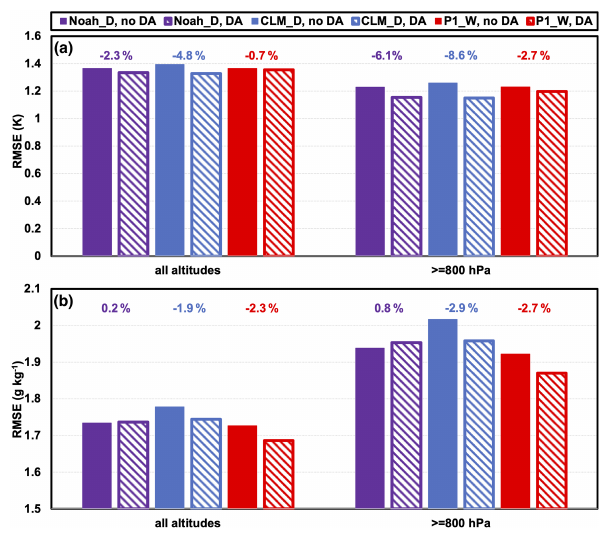
Figure 6. Evaluation of (a) air temperature and (b) water vapor mixing ratios from several WRF-Chem simulations with the B- 200 aircraft observations during the 2016 ACT-America campaign. The RMSEs are summarized in barplots based on model compar- isons against observations at all altitudes and near the surface (i.e., ≥ 800hPa). Colored texts above the barplots indicate the SMAP DA impacts on RMSEs. The B-200 flight paths are indicated in Fig.